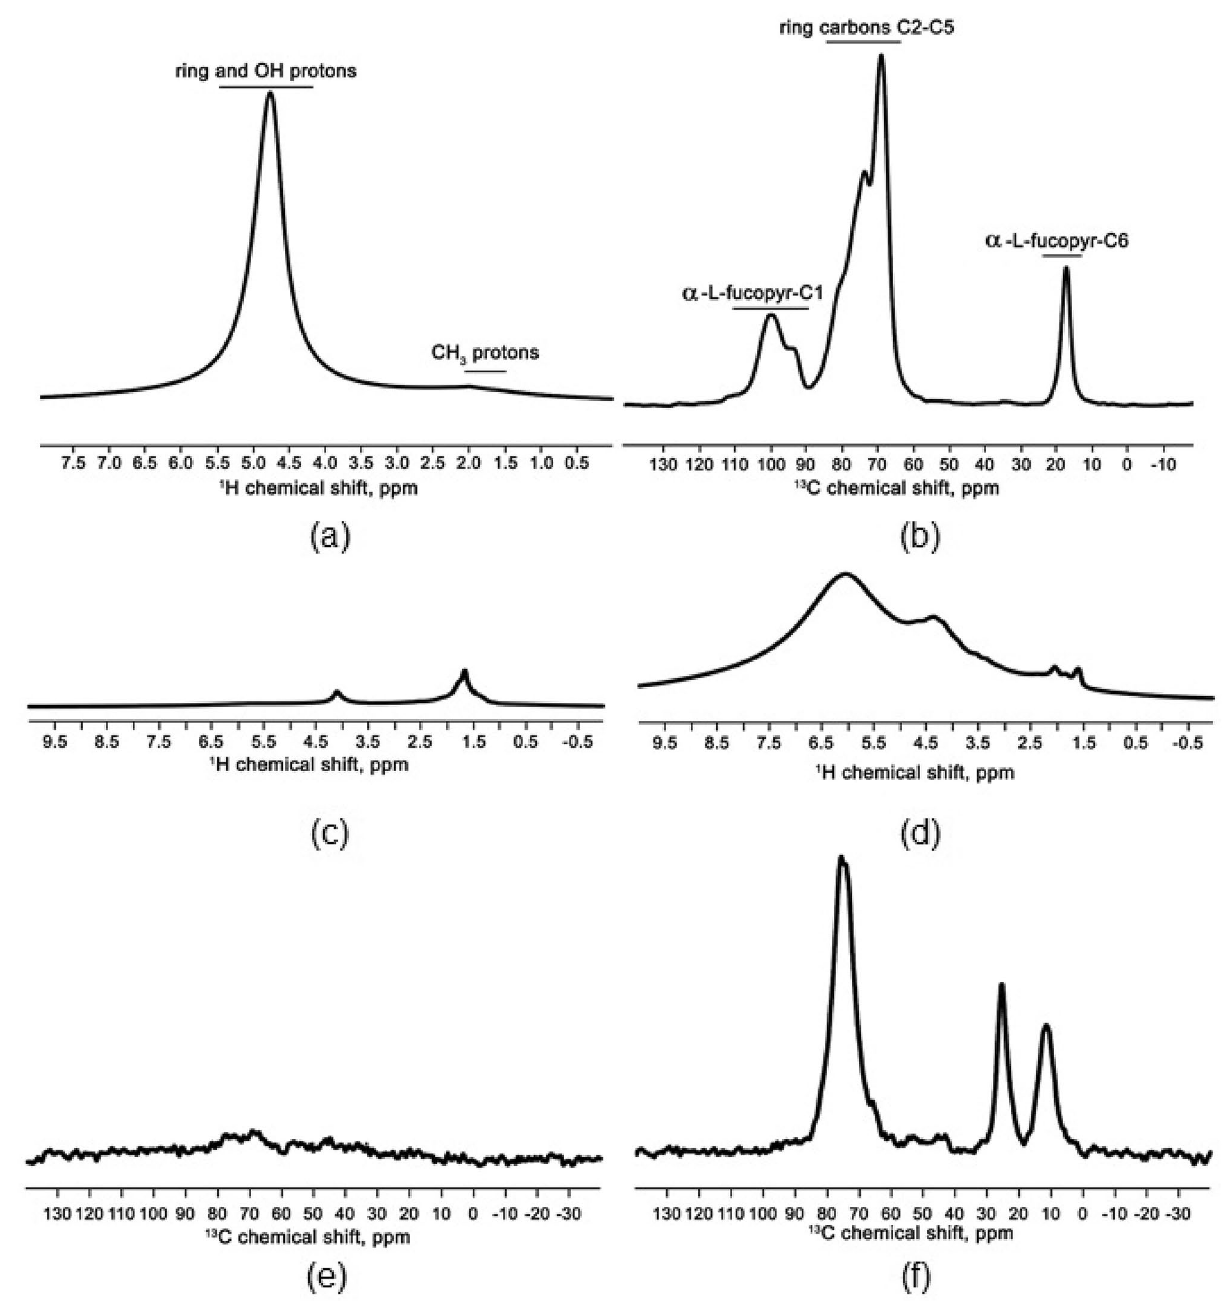
Figure 3. Solid-state DP/MAS SE 1 H NMR spectrum ( a ) and CP/MAS 13 C NMR spectrum ( b ) of fucoidan at room temperature. Solid-state DP/MAS 1 H NMR spectra for MgO/Fuc ( c ) and ZrO 2 /Fuc ( d ) at room temperature; and solid-state CP/MAS 13 C NMR spectra for MgO/Fuc ( e ) and ZrO 2 /Fuc ( f ) at room